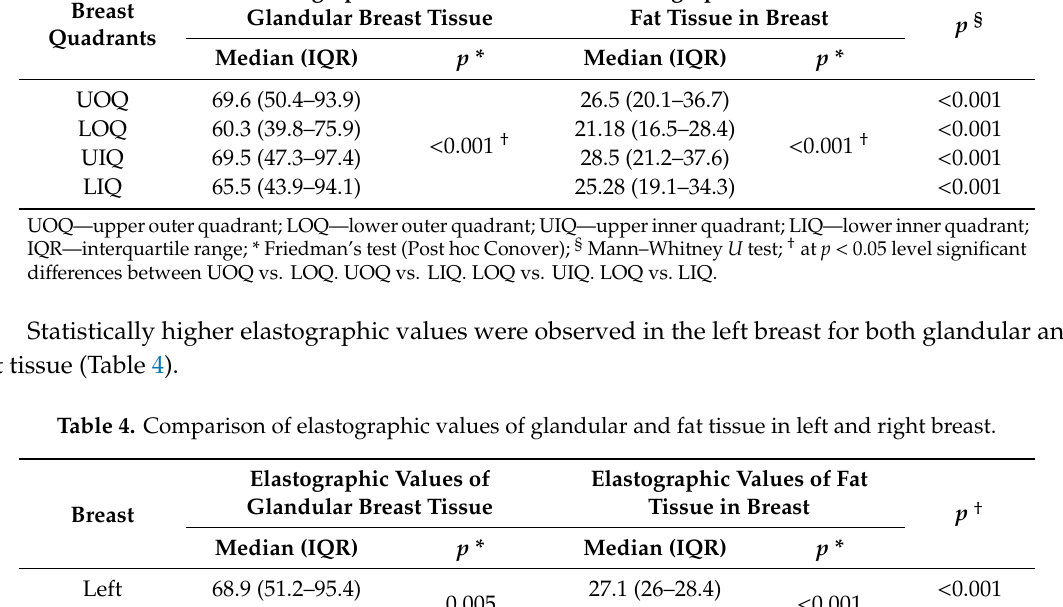
Table 3. Comparison of elastographic values of glandular and fat tissue in di ff erent breast quadrants. Elastographic Values of Breast Quadrants